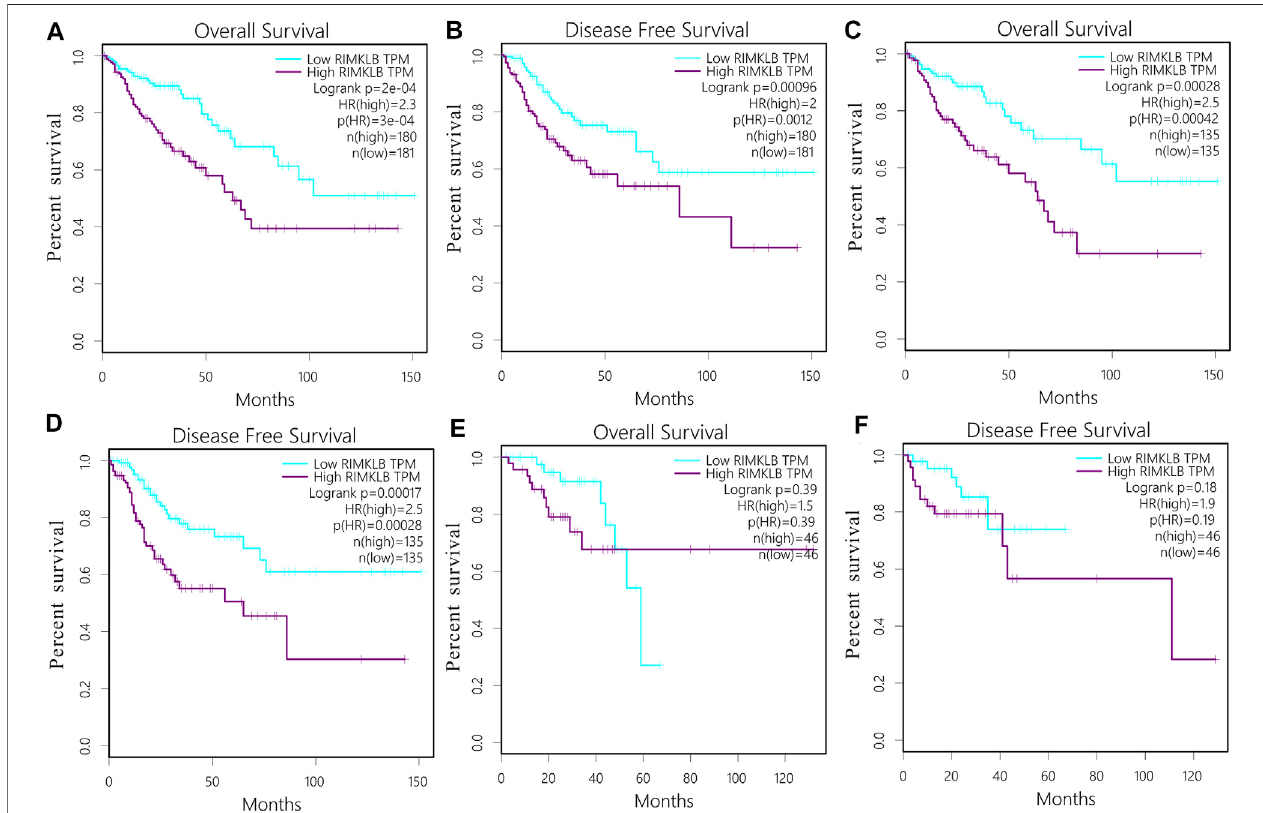
FIGURE 3 | Survival curves and subgroup analysis of patients with colorectal cancer from TCGA cohort. Overall survival (OS) and disease free (DFS) curves comparing the high and low expression of RIMKLB in CRC (A,B) ; OS and DFS curves comparing the high and low expression of RIMKLB in colon cancer (C,D) and rectum cancer (E,F) .